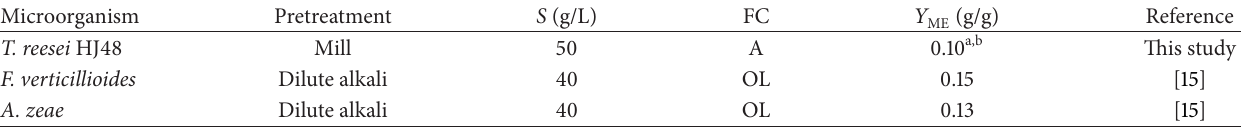
Table 5: Fermentation performance of diverse microorganisms using sugarcane